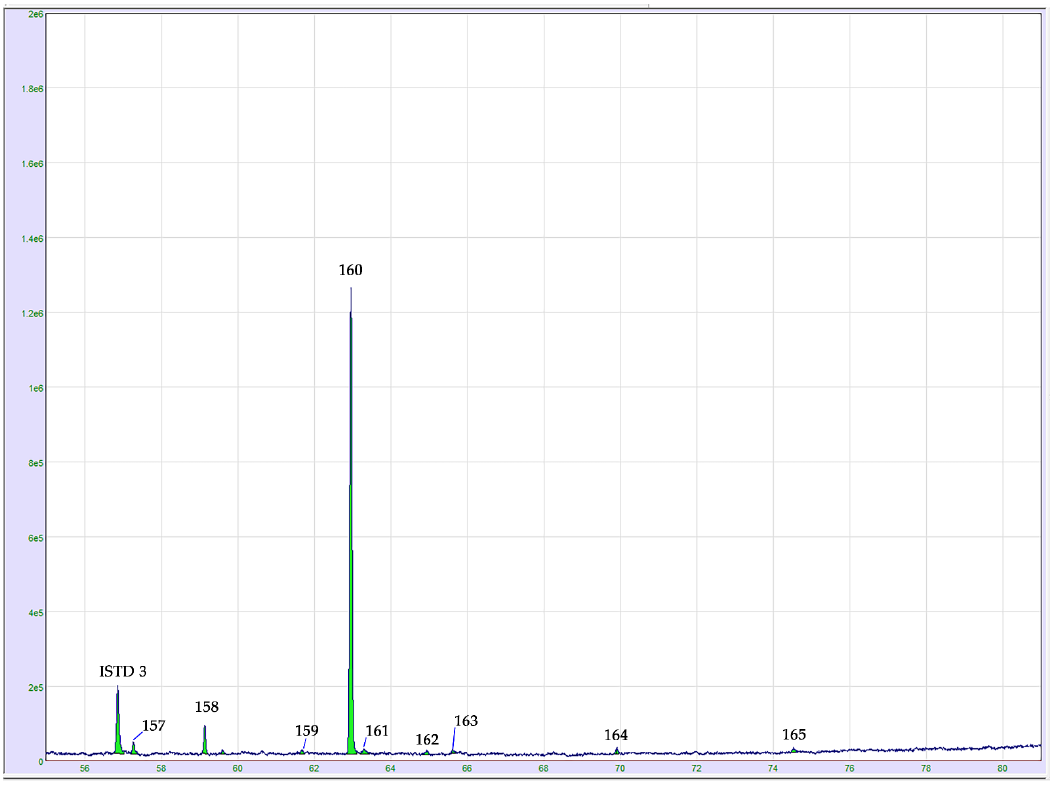
Figure 4. GC-MS chromatogram expansion of the cannabinoid region in dried hemp inflorescences, cv. Kompolti. For peak assignment, see the compounds listed in Table 1. Abbreviation: ISTD 3: cannabigerorcin internal standard.